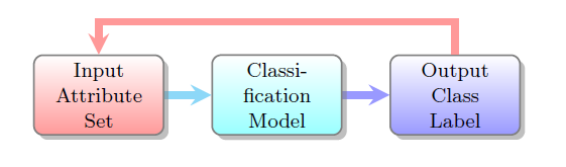
Figure 2. Classification